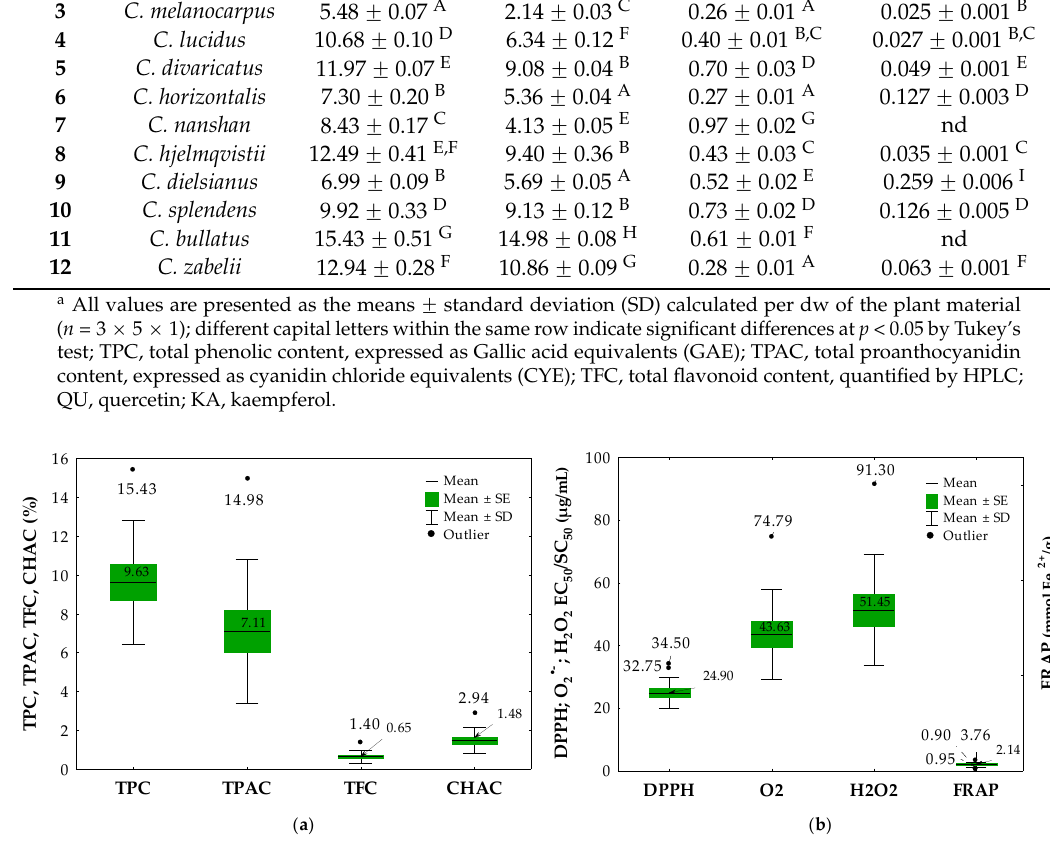
Figure 2. Box-whisker plot analysis of: ( a ) total contents of phenolics (TPC), proanthocyanidins (TPAC) flavonoids (TFC) and chlorogenic acid isomers (CHAC); and ( b ) antioxidant and reducing activity tested by SET and HAT-type methods in the Cotoneaster leaf samples. Mean values ± standard errors (SE) and standard deviation (SD).